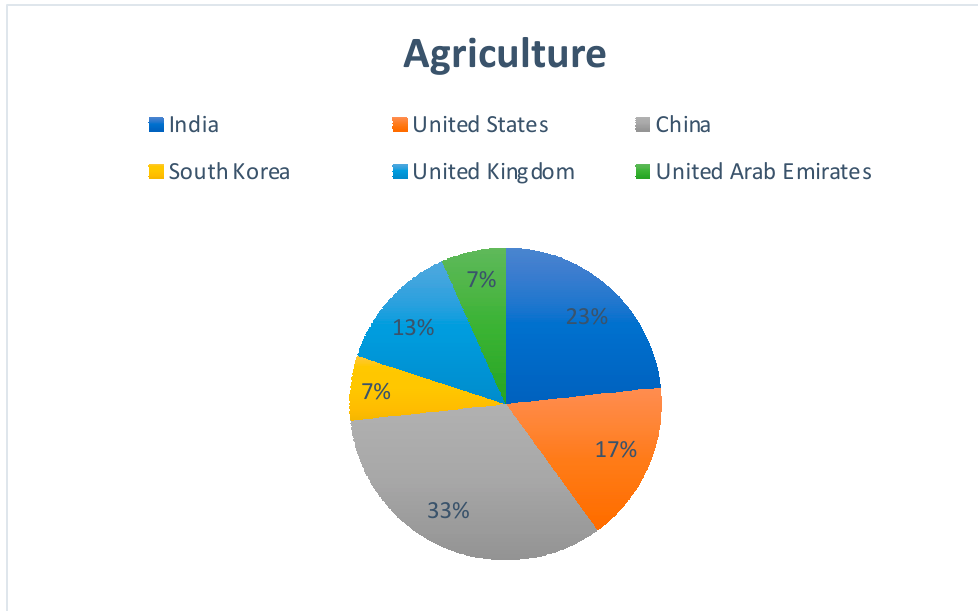
Figure 7. Region-specific publication distribution for Blockchain–Cloud and Agriculture.